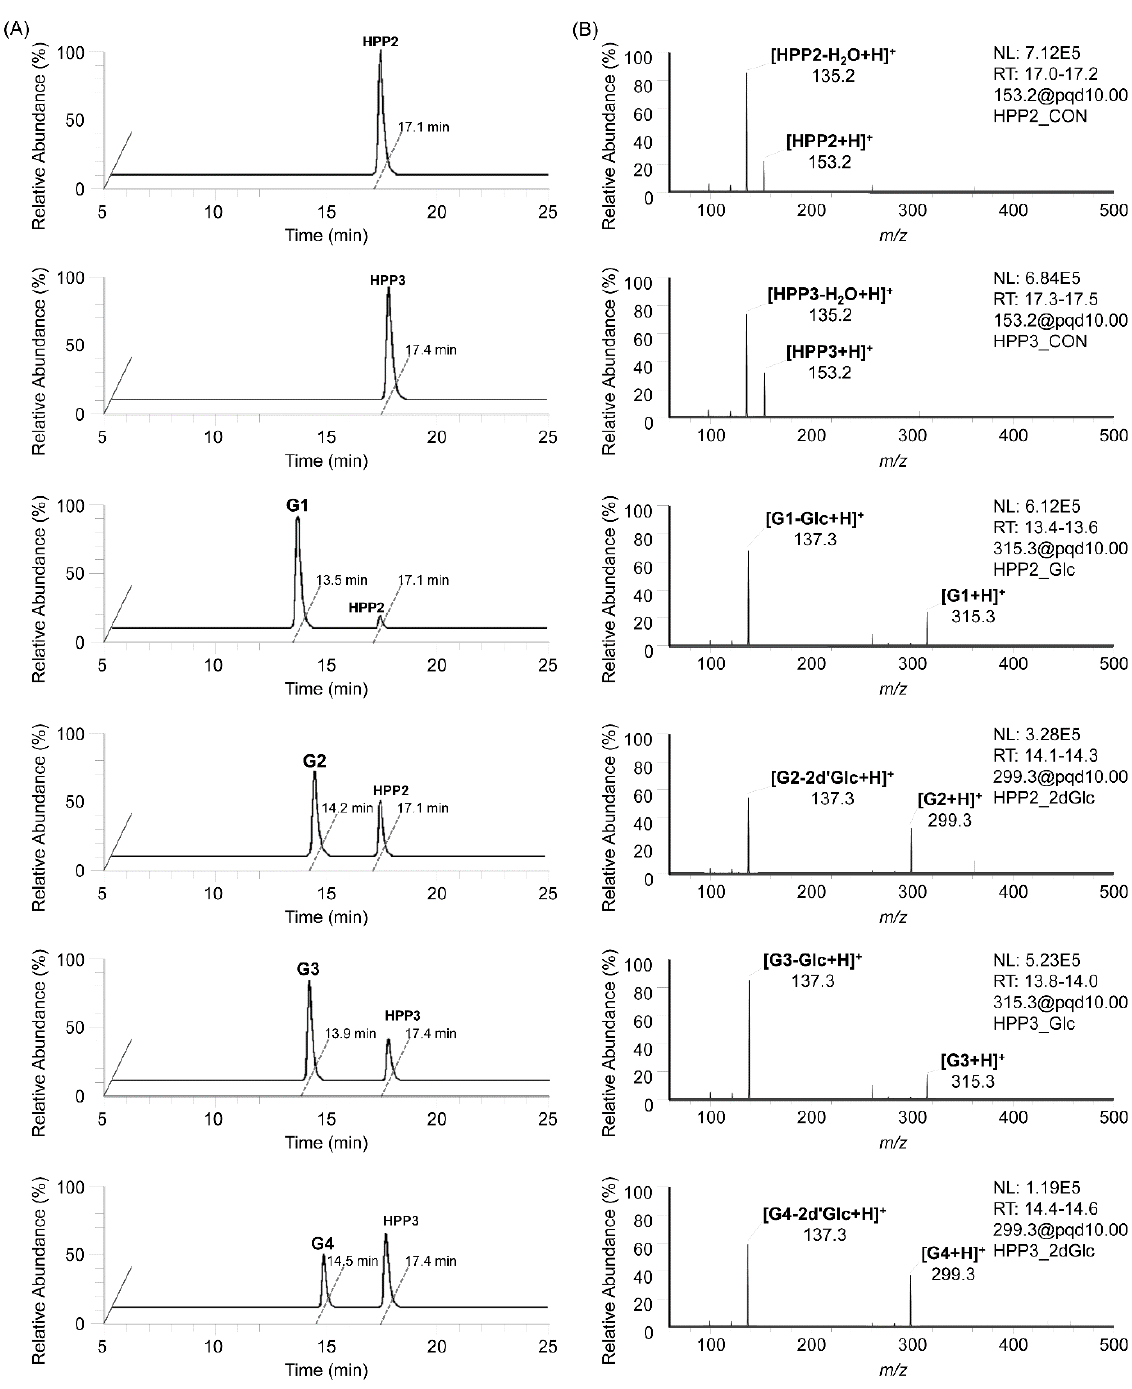
Figure 2. HPLC-MS/MS data of in vitro StSPGT enzymatic reactions. ( A ) HPLC-MS/MS traces of StSPGT’s glycosyl -transferring reactions with both hydroxyphenyl-2-propanol (HPP2) and hydroxyphenyl-3-propanol (HPP3) (as glycosyl acceptors) and two nucleotide sugars, uridine diphosphate-glucose (UDP-Glc) and thymidine diphosphate-2 ′ -deoxyglucose (TDP-2 ′ dGlc). ( B ) Tandem MS spectra of four kinds of glycoside products obtained.